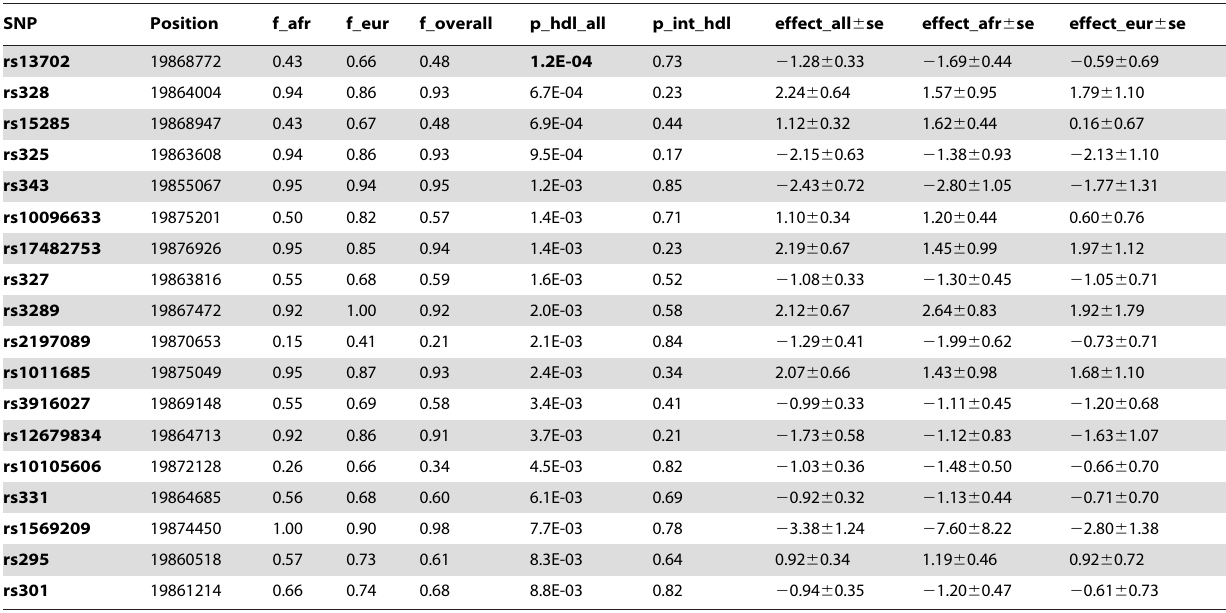
Table 5. Effect size of LPL variants on HDL-C